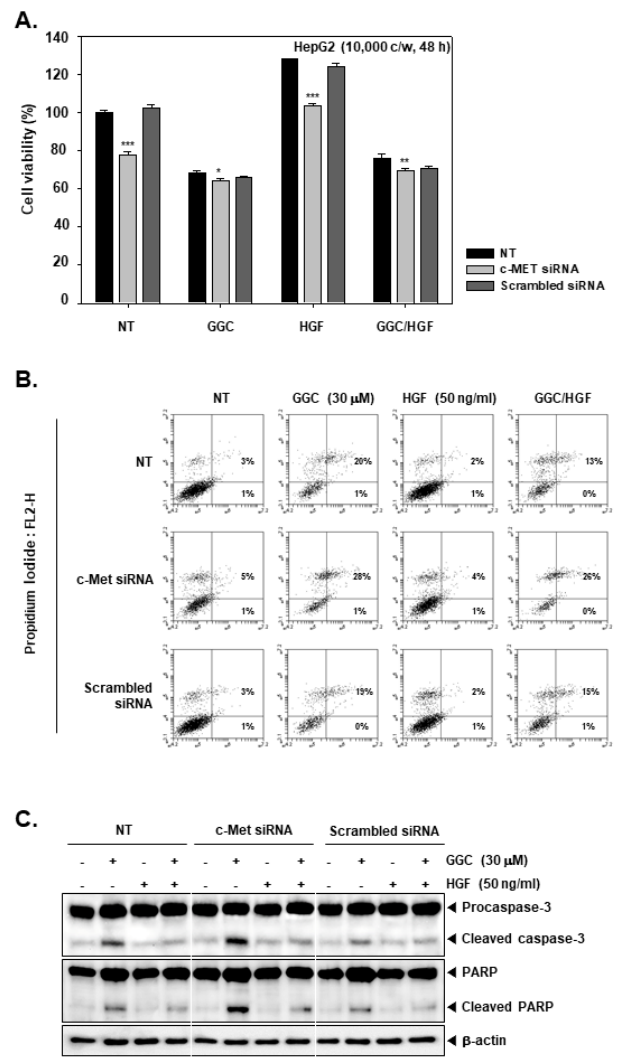
Figure 4. E ff ect of c-Met knock down on apoptosis. HepG2 cells (5 × 10 4 cells / well) were transfected Figure 4. Effect of c-Met knock down on apoptosis. HepG2 cells (5 × 10 4 cells/well) were transfected